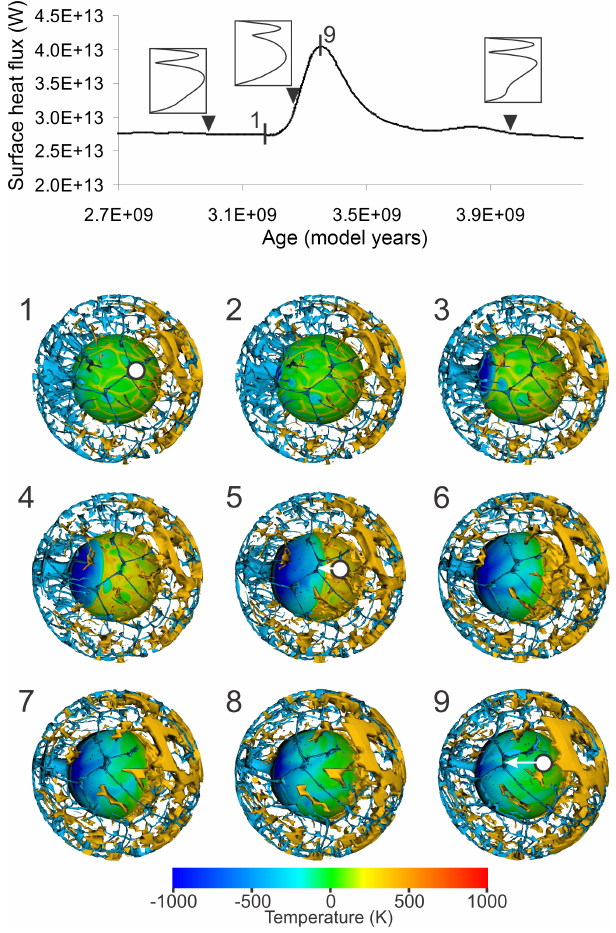
Figure 2. Visualization of Case 1, peak 1 shown in Fig. 1. In ad- dition to surface heat flux, the graph provides three insets show- ing the absolute radial mass flux through the modelled mantle and the depth of the “pinch point” indicating how much 660 is restrict- ing mass exchange between upper and lower mantle. Evenly spaced temperature anomaly snapshots (1–9) cover the indicated region of the surface heat flux curve. The white dot in 1, 5 and 9 is fixed, and arrows show how the near surface material has moved. Temperature anomaly is plotted just above the CMB and as ± 400K isosurfaces.